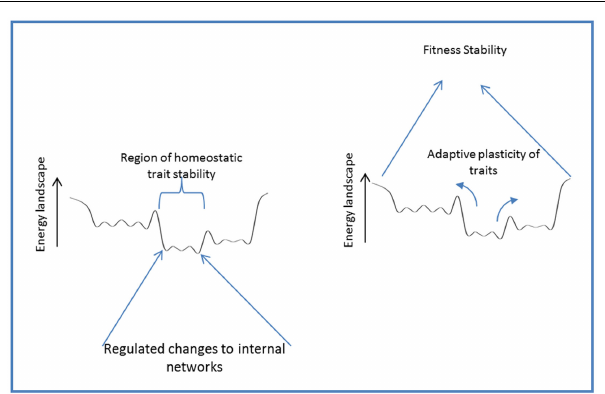
FIGURE 6 | Homeostasis and adaptive phenotypic plasticity: different perspectives of a similar